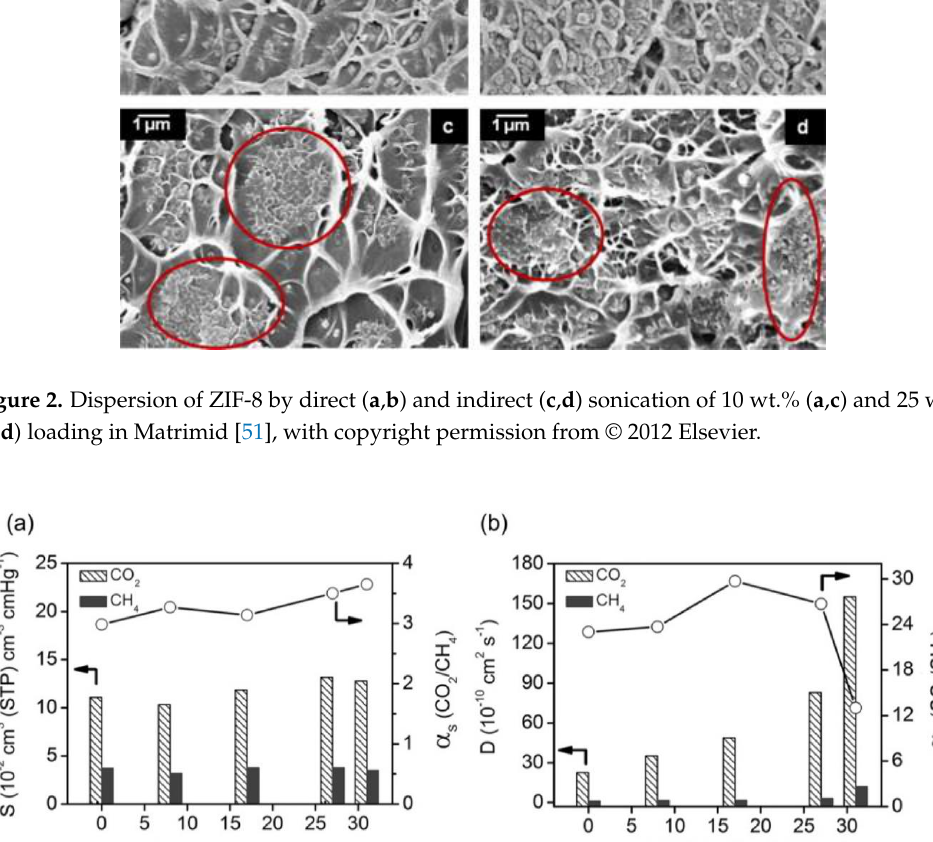
Figure 2. Dispersion of ZIF-8 by direct ( a , b ) and indirect ( c , d ) sonication of 10 wt.% ( a,c ) and 25 wt.% (b,d) loading in Matrimid [51], with copyright permission from © 2012 Elsevier.